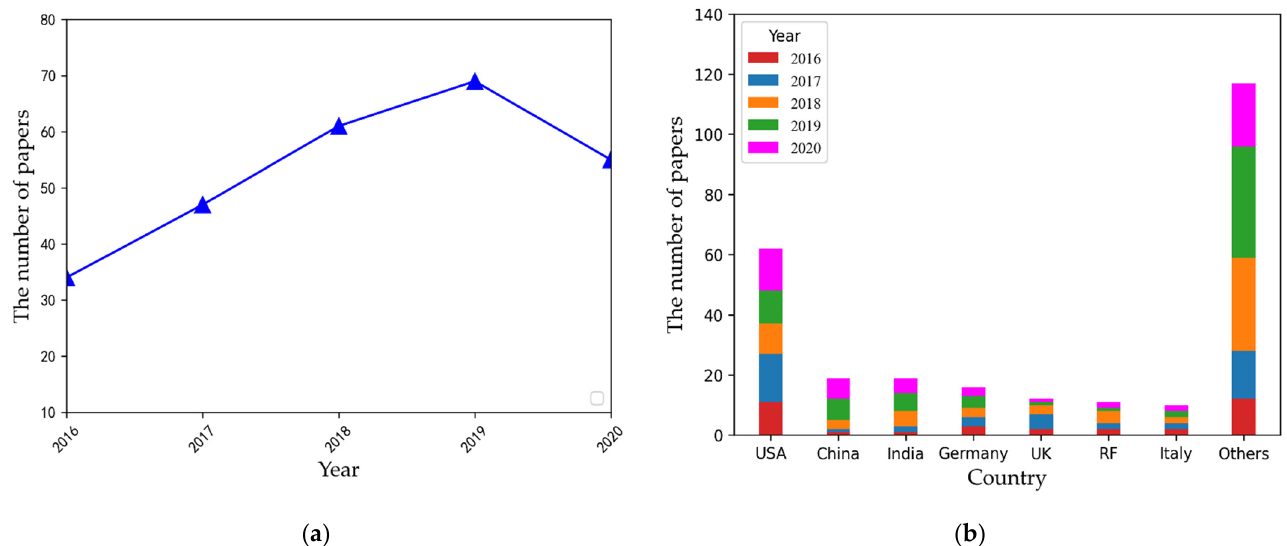
Figure 2. ( a ) Number of papers related to geospatial data published per year; ( b ) Number of papers related to geospatial data published by country.